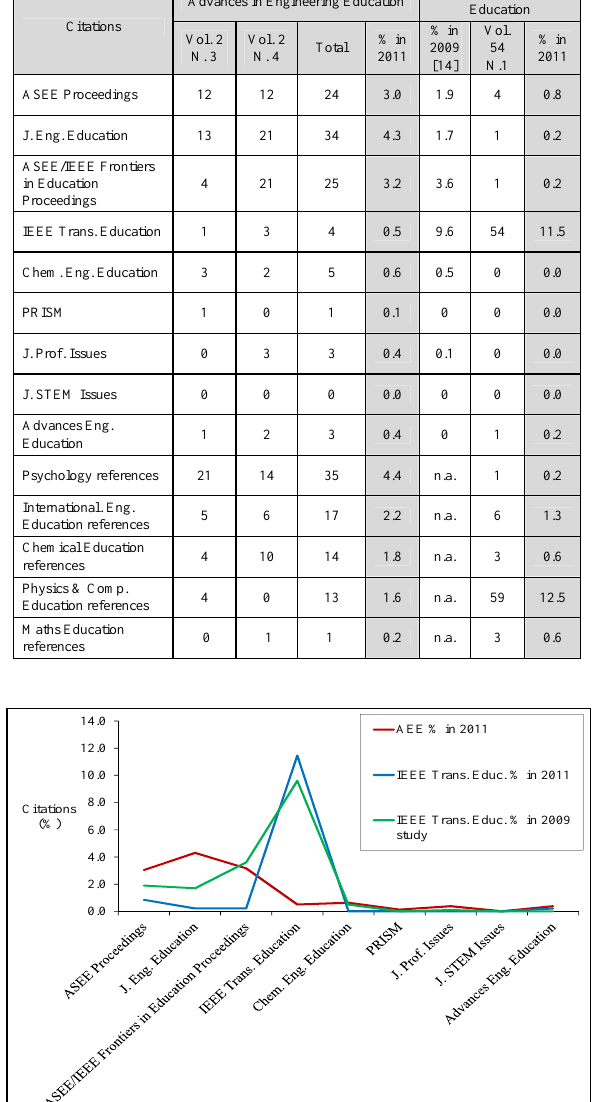
Figure 5. Comparative citation analysis of the journals in 2011 and 2009 using Wankat’s